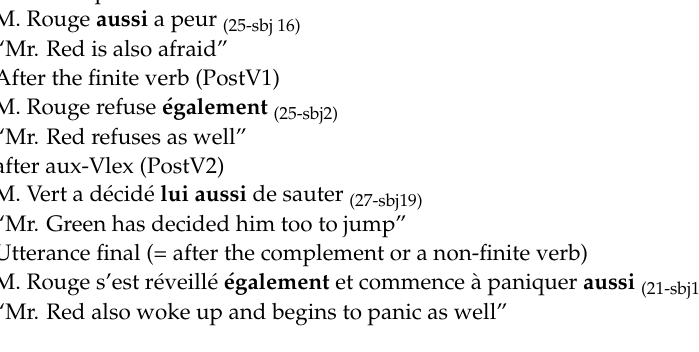
“also Mr. Green was now awake and was scared” The remnant occurrences correspond to sentences with a linear order different from SVO. When the sentence starts with a non-subject constituent, the subject and the particle follow the finite verb: in this case, auch can be placed either before the subject (ex.8a) or after it, as in (8b).